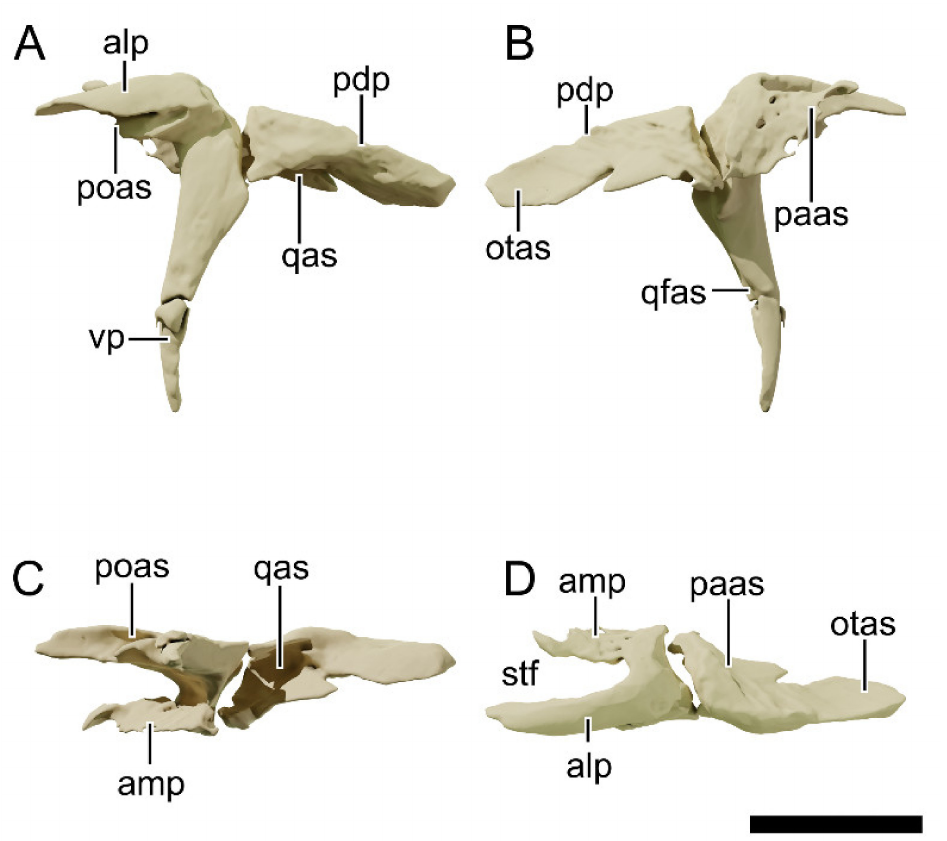
Figure 16. Digital reconstruction of the left squamosal of NHMD 164741. ( A ) Lateral view. ( B ) Medial view. ( C ) Ventral view. ( D ) Dorsal view. Abbreviations: alp, anterolateral process; amp, anteromedial process; otas, articular surface for the otoccipital; paas, articular surface for the parietal; pdt, posterodorsal process; poas, articular surface for the postorbital; qas, articular surface for the quadrate; qfas, articular surface for the quadrate flange; stf, supratemporal fenestra. Scale bar = 20